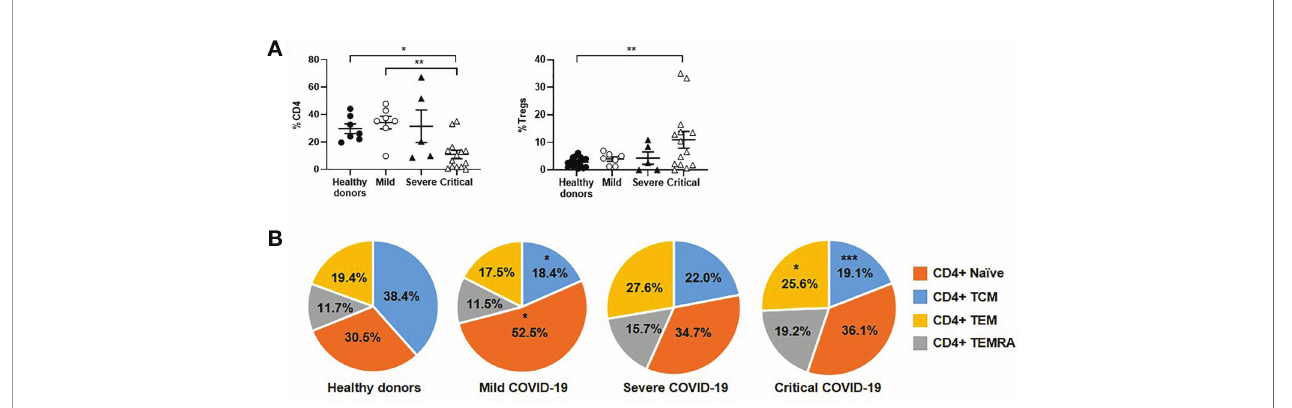
FIGURE 2 | Analysis of CD4+ T cell subpopulations in patients with different stages of COVID-19. The levels of CD4+ T cells and Tregs (A) , as well as the distribution of CD4 subpopulations (B) , were analyzed in PBMCs of patients with mild, severe and critical COVID-19, in comparison with healthy donors. Each dot corresponds to one sample and lines represent mean ± SEM. Statistical signi fi cance was calculated using one-way ANOVA and Tukey ’ s multiple comparisons test. *p < 0.05; **p < 0.01.